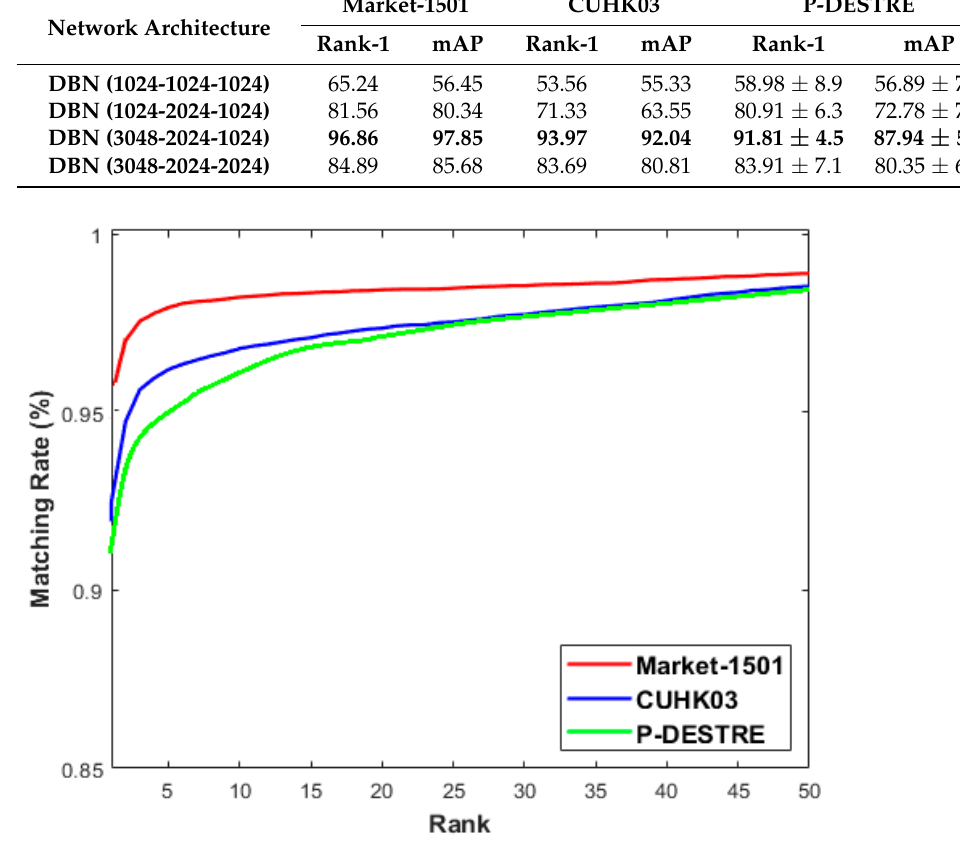
Figure 9. CMC curves for the best trained DBN model over three different ReID datasets.